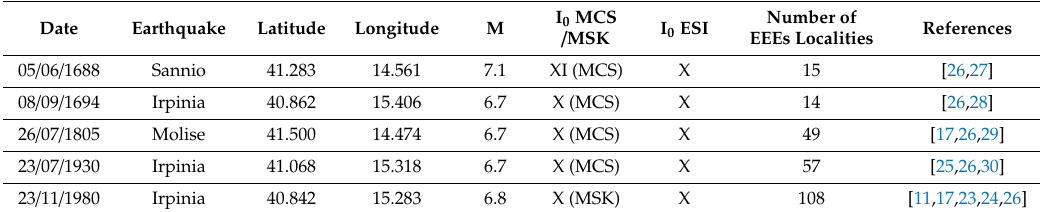
Table 1. Details of the analyzed earthquakes. Epicentral coordinates and magnitude (M) are from [14]; I 0 : epicentral